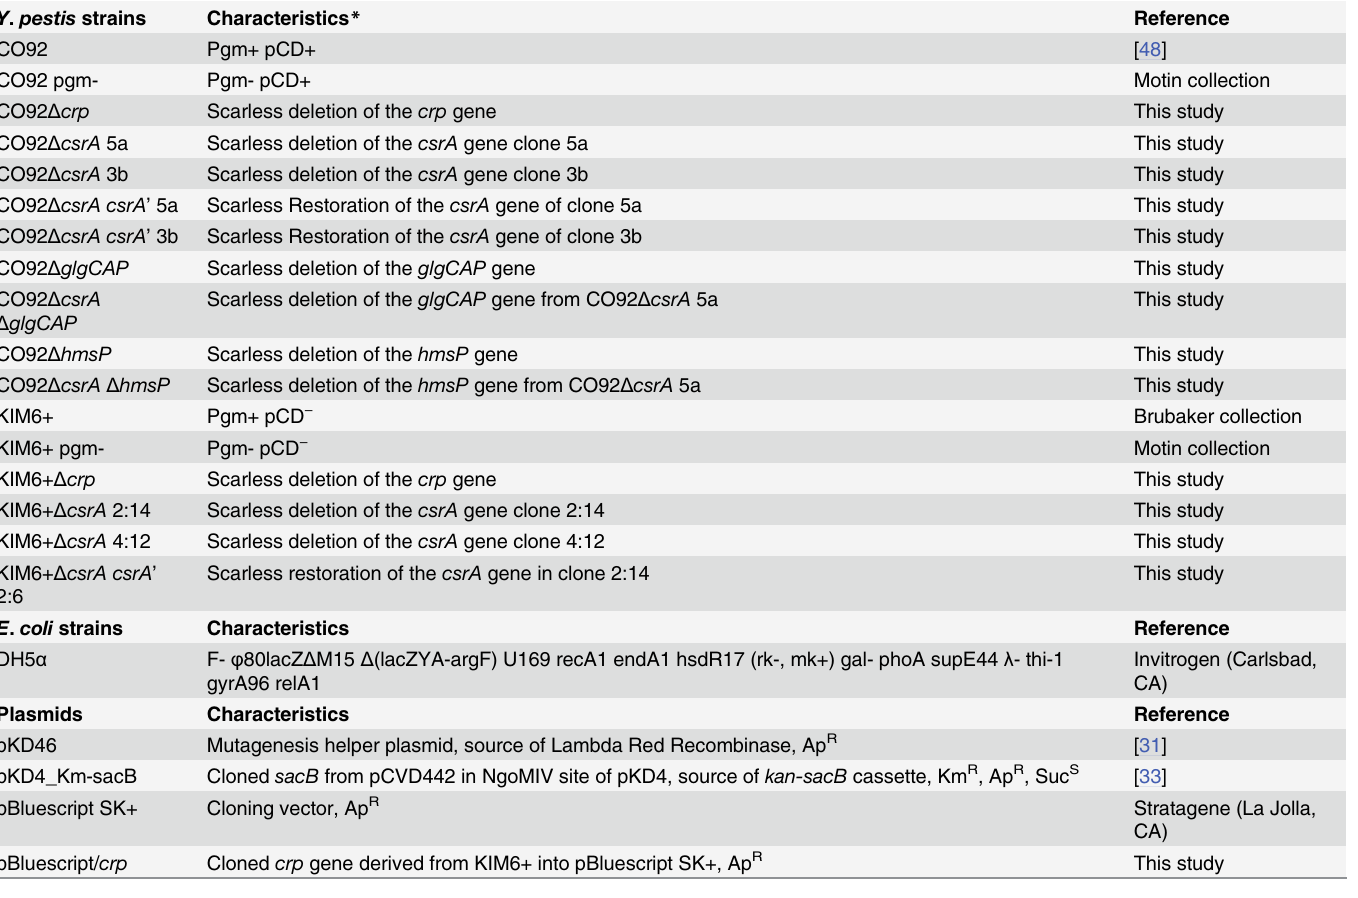
Table 1. Bacterial Strains and